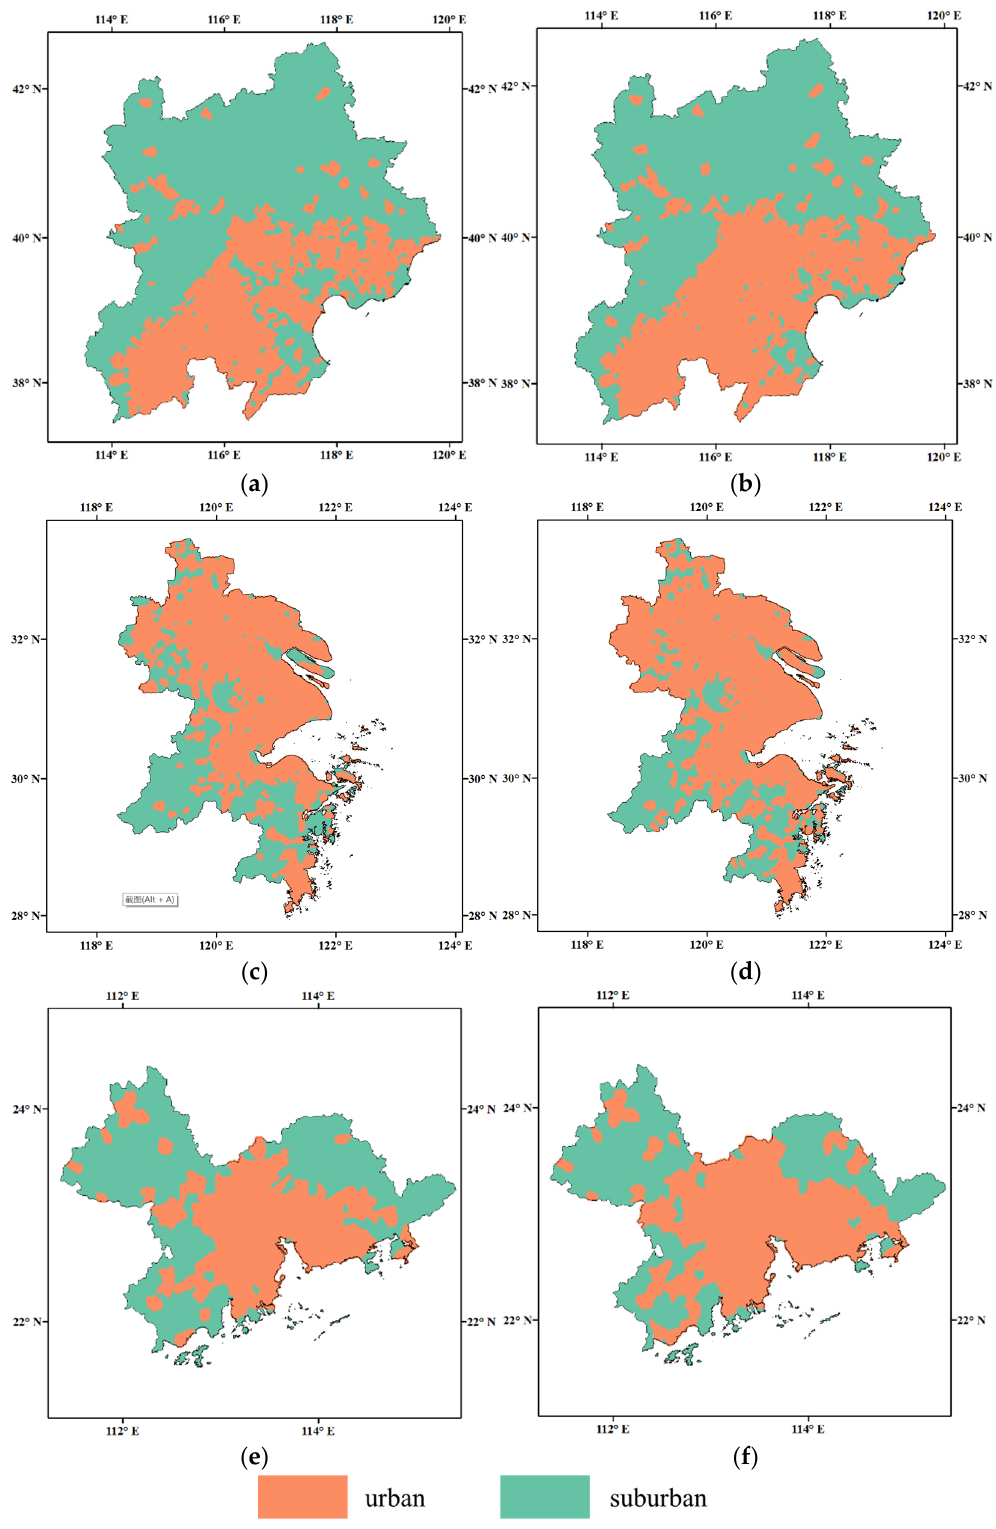
Figure 2. The distribution of urban and suburban areas of BTH, YRD, and PRD in 2000 and 2020. ( a ) BTH in 2000. ( b ) BTH in 2020. ( c ) YRD in 2000. ( d ) YRD in 2020. ( e ) PRD in 2000. ( f ) PRD in